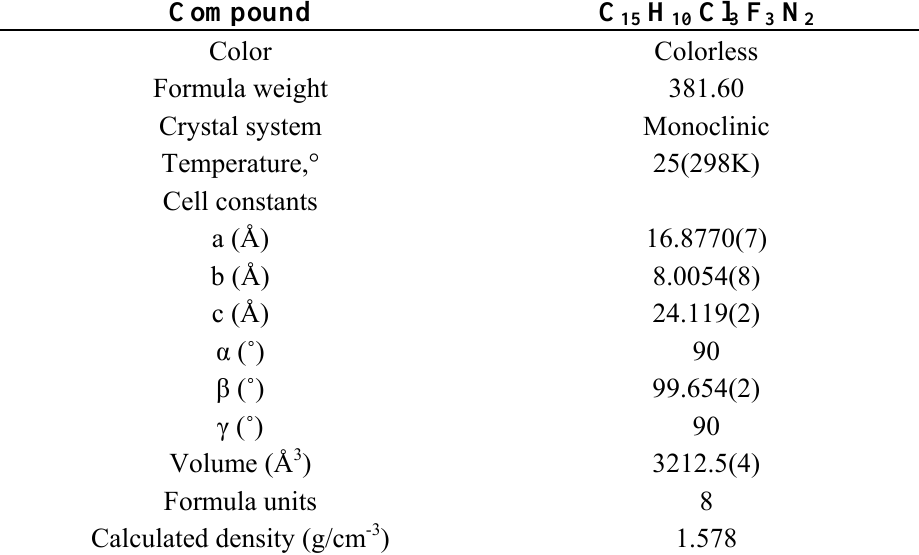
Table 1. Crystal data and summary of data collection and structure